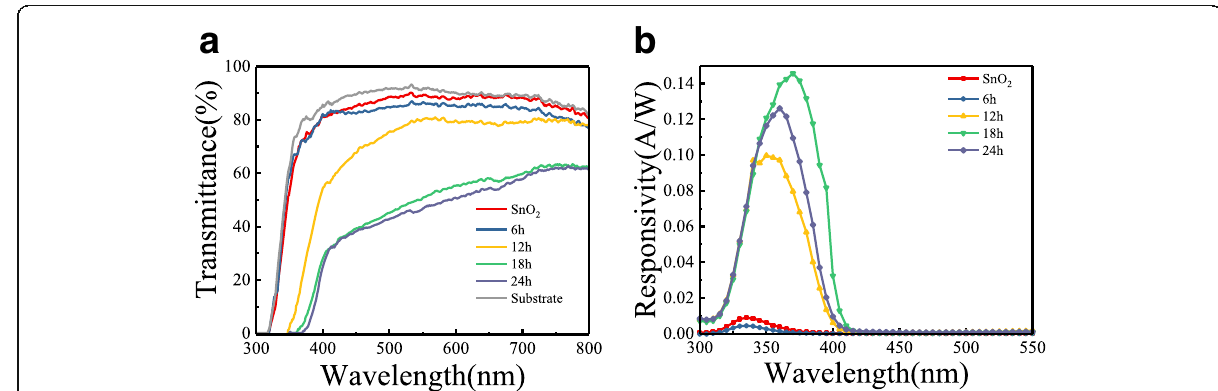
Fig. 3 The UV-visible transmittance spectra and responsivity spectrum of photodetectors. a Spectrum of transmittance for FTO glass substrate, SNAs, and STNMAs with different growth time. b Responsivity spectrum of photodetectors based on SNAs and